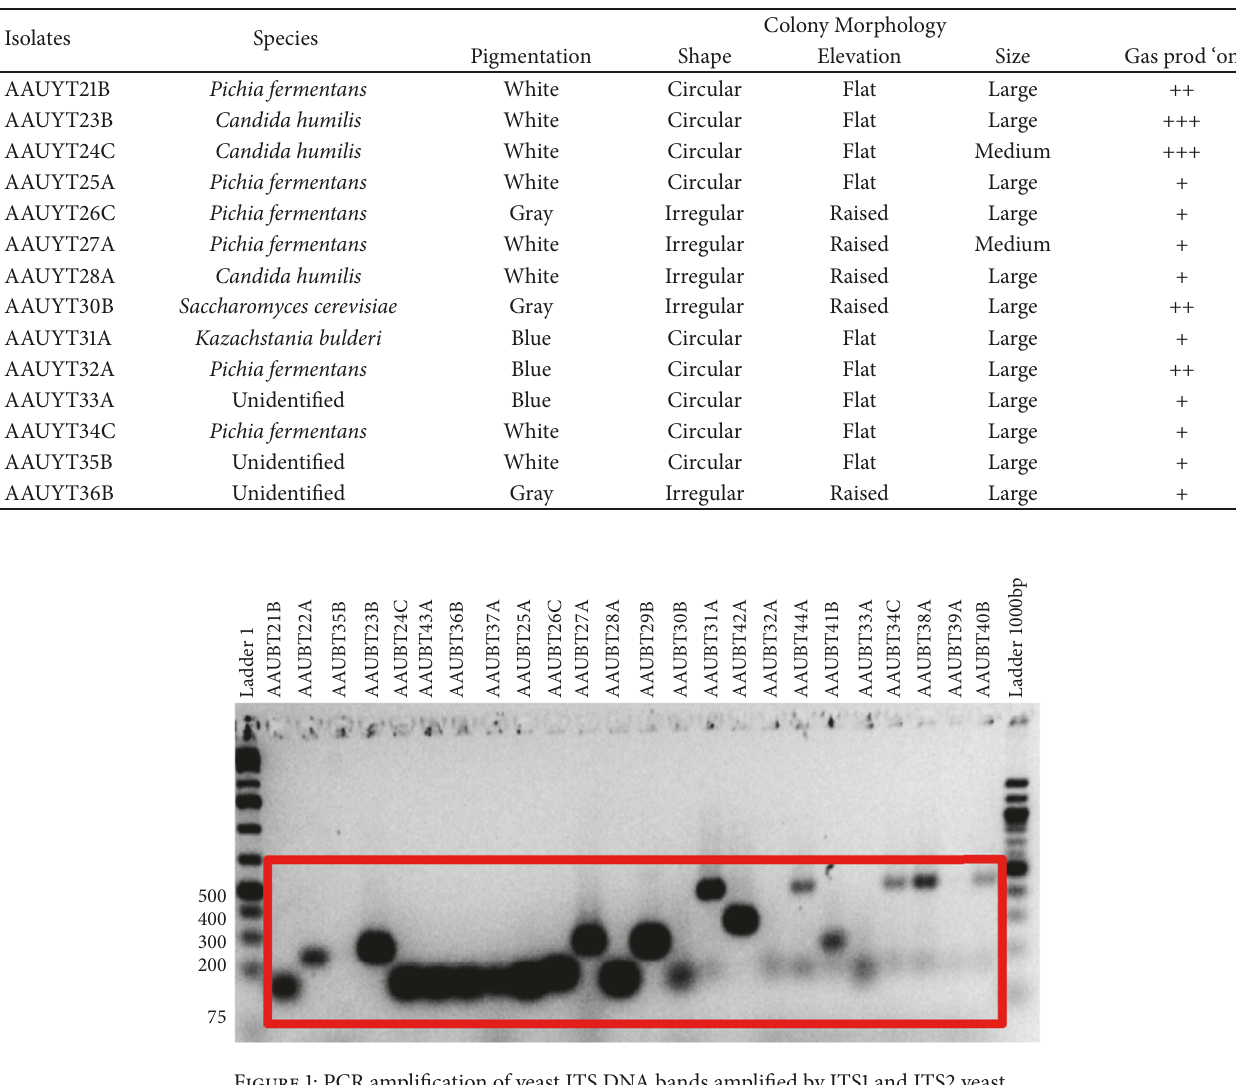
Table 1: Morphological characteristics and gas production of the isolated yeast.